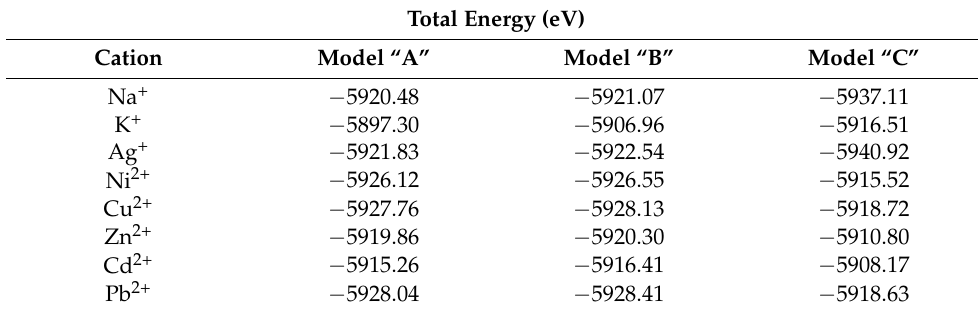
Table 2. Total energies calculated for the model FAU